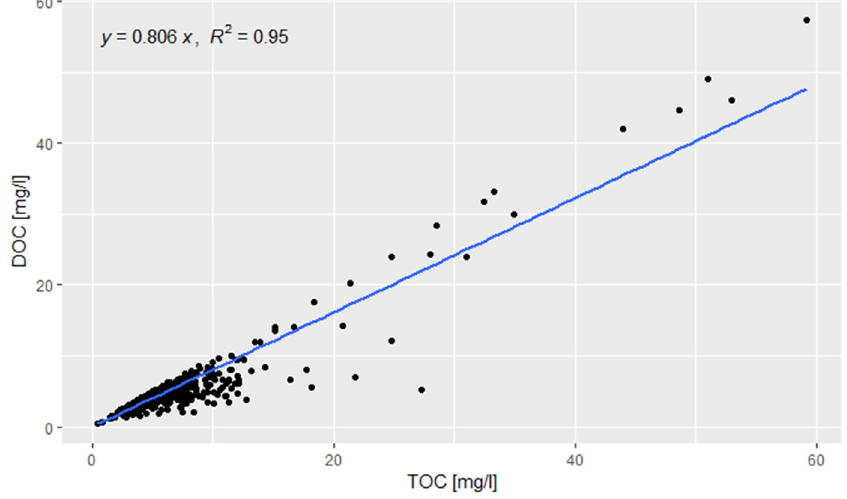
Figure 3. The relationship between the measured concentrations of DOC and TOC in Bulgarian surface waters.